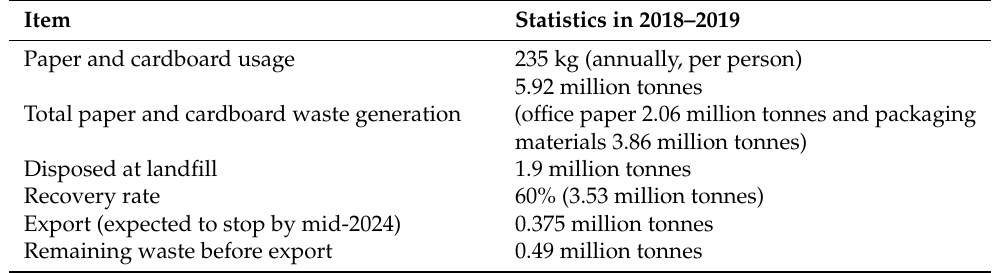
Table 1. Paper and cardboard waste status of Australia [3].